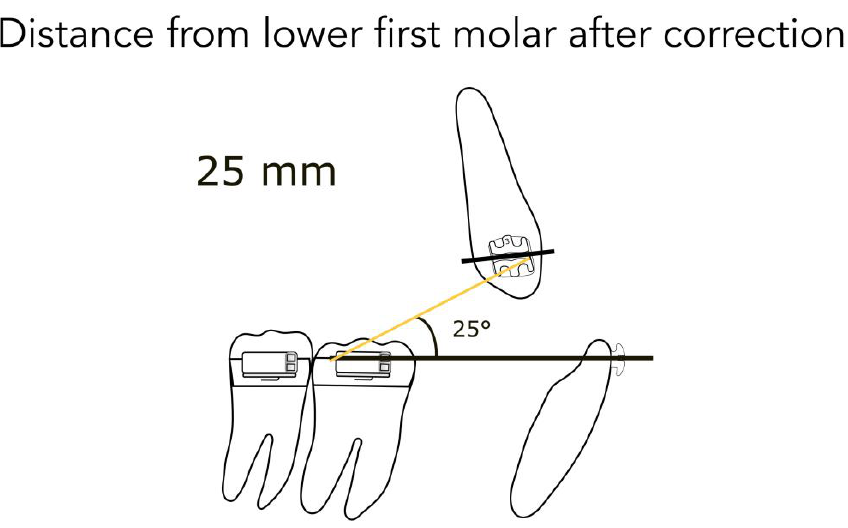
J. Funct. Morphol. Kinesiol. 2019 , 4 , x FOR PEER REVIEW Figure 7. Distance from the lower first molar after correction. Figure 7. Distance from the lower first molar after correction. Figure 7. Distance from the lower first molar after correction.